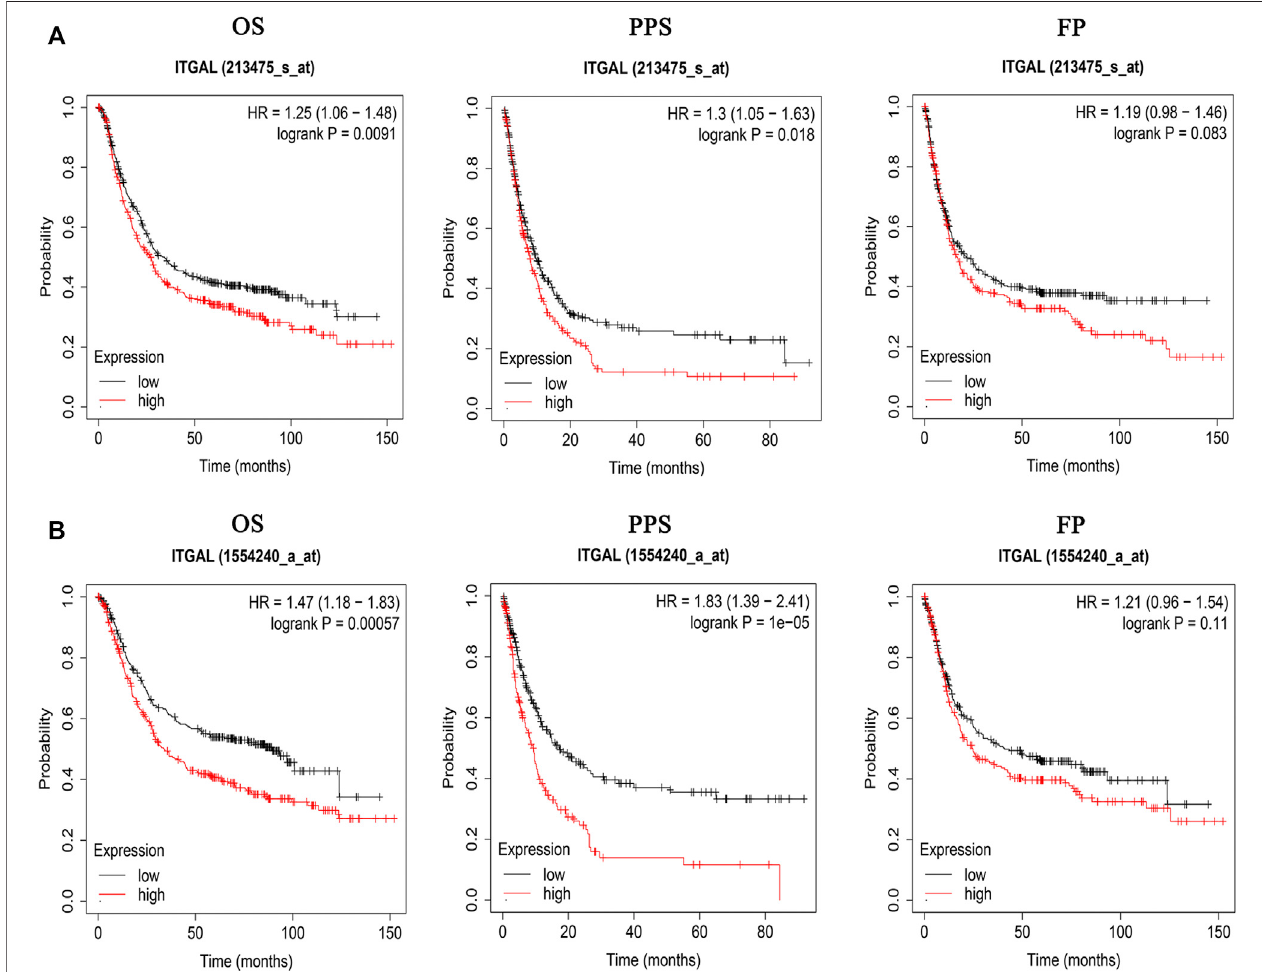
FIGURE3| Kaplan – Meiersurvivalcurvescomparing thehigh andlowexpression ofITGALingastriccancerinKaplan – Meierplotterdatabases. (A) Survivalcurves of OS, PPS, and FP in the gastric cancer cohort (213475-s-at). (B) OS, PPS, and FP survival curves of gastric cancer (1554240-a-at). OS, overall survival; PPS, post- progression survival; FP, fi rst